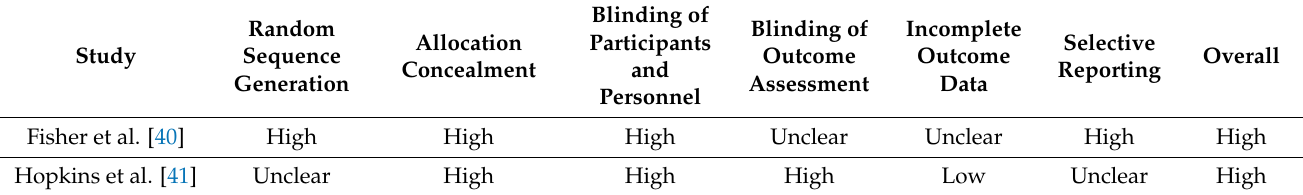
Table 4. Risk of bias assessment ( n =